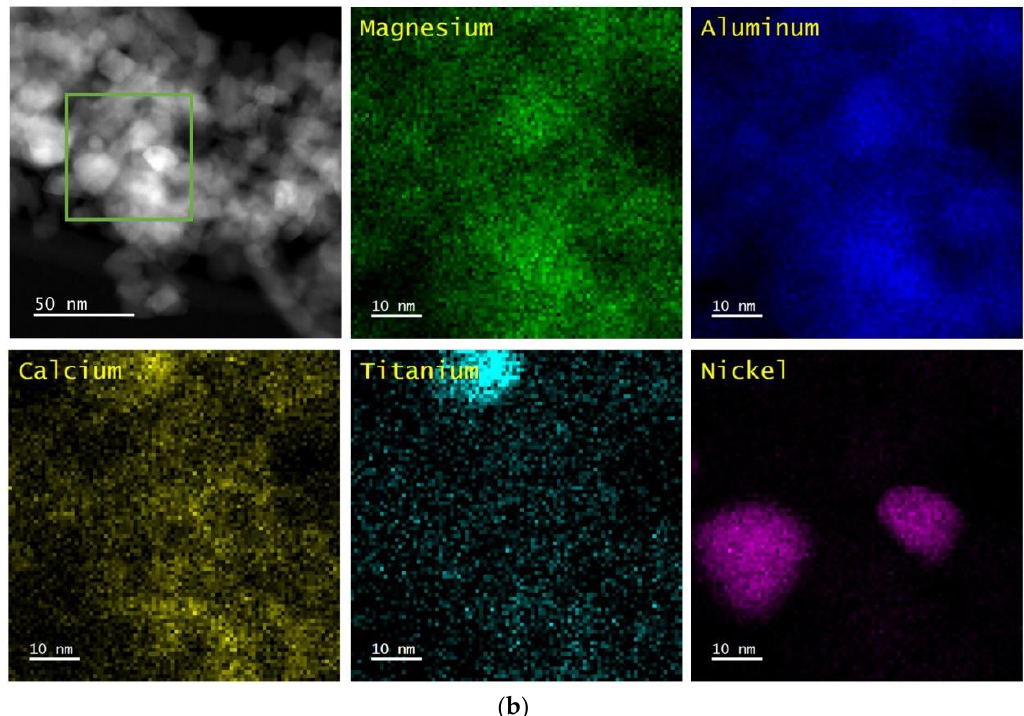
Figure 1. ( a ) Representative Scanning Transmission Electron Microscopy (STEM) results for Ni/CaTiO 3 /MgAl 2 O 4 after 1073 K oxidation followed by 773 K reduction with Energy Dispersive X-ray Spectroscopy (EDS) maps of corresponding elements. ( b ) Representative STEM results for Ni/CaTiO 3 /MgAl 2 O 4 after 1073 K oxidation followed by 1073 K reduction with EDS maps of corresponding elements.